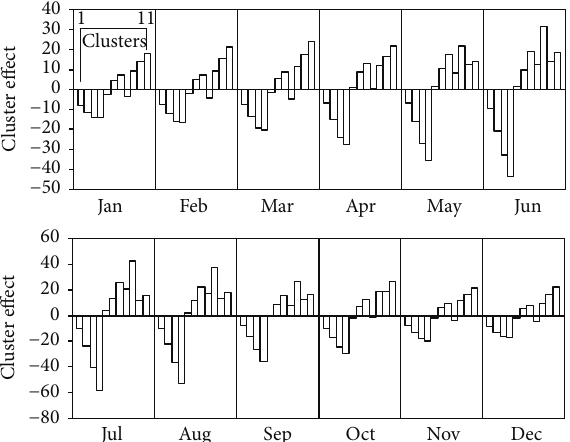
Figure 6: The contribution/effect of each cluster in the spatiotem- poral variation of ET 𝑜 in the Greek territory as it is described by the sum term inside